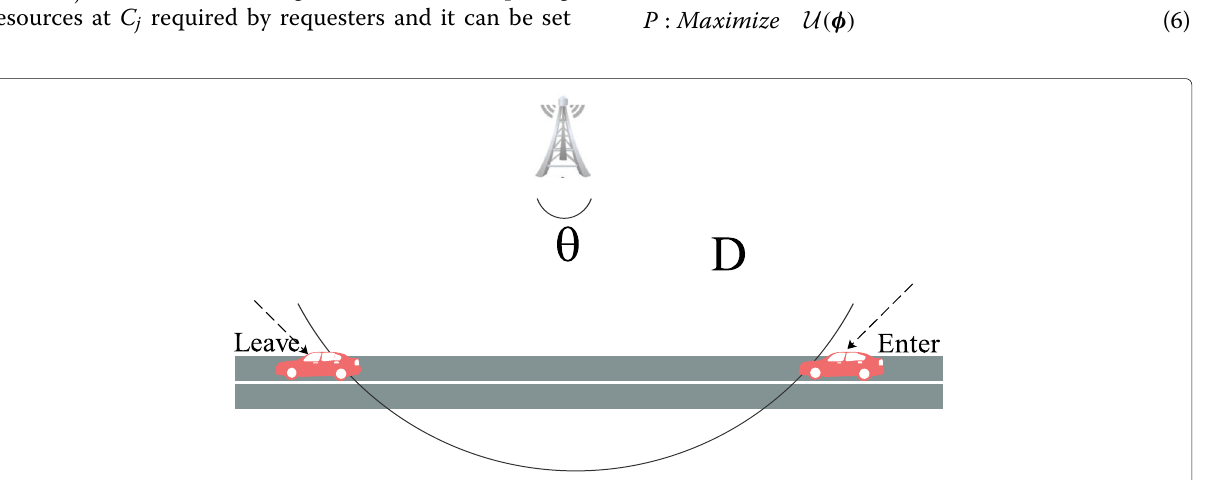
Fig. 2 An example of the dwell time for vehicle in one